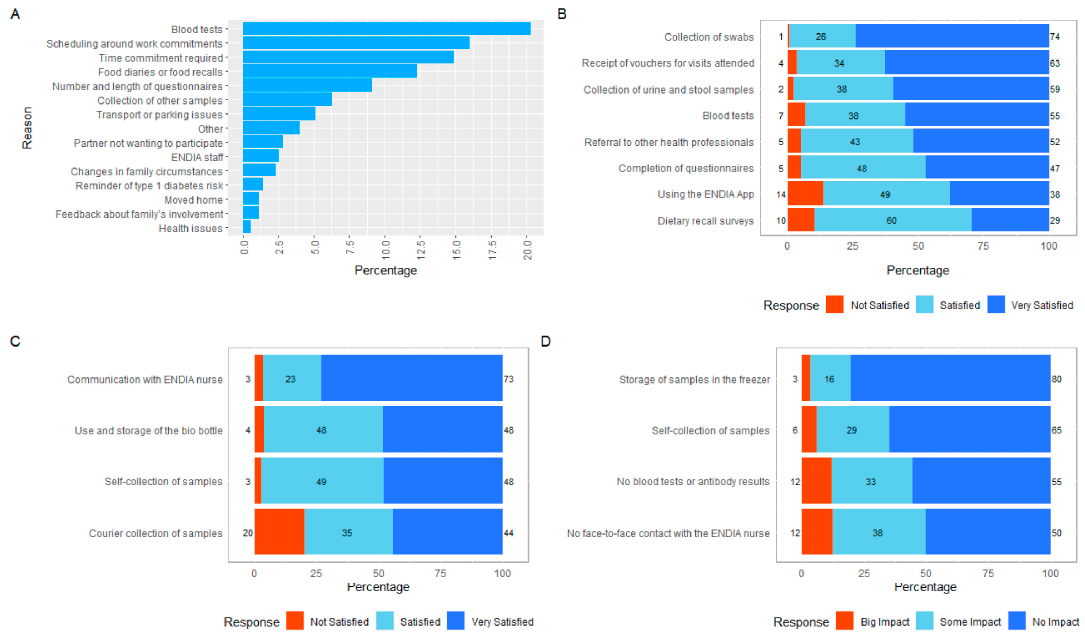
Figure 4. ( A ) Reasons provided by caregivers for thoughts of leaving ENDIA. ( B ) Caregiver satis- faction with the study protocol. ( C ) Caregiver satisfaction with the RPP. ( D ) Impact on the caregiver of the protocol changes implemented during COVID-19 restrictions.